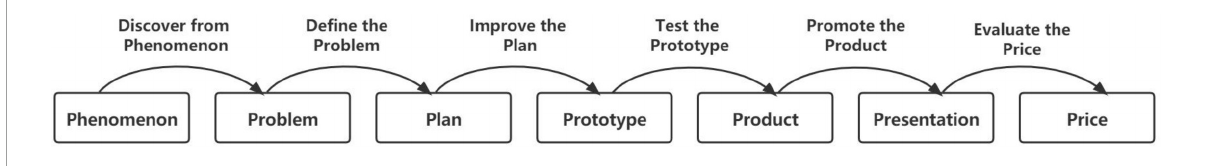
FIGURE1 The 7P model of PBP.